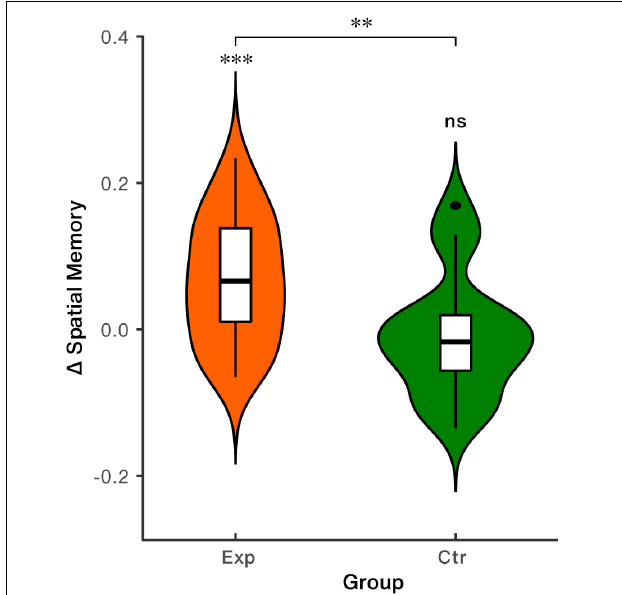
FIGURE 6 | Spatial memory performance. Exp: the experimental group; Ctr: the control group; ∗∗ p < 0.01; ∗∗∗ p < 0.001; ns,